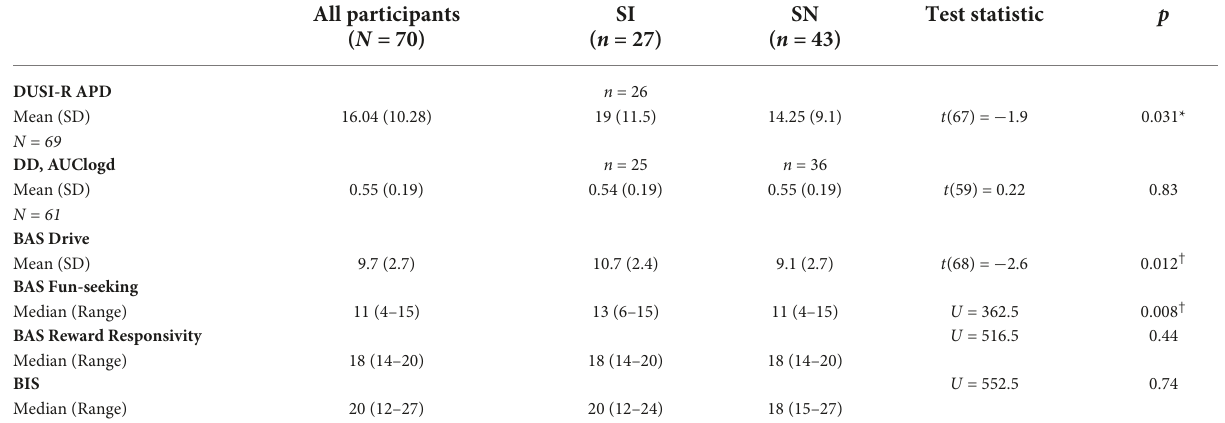
TABLE 2 DUSI-R APD, DD, and BIS/BAS results.